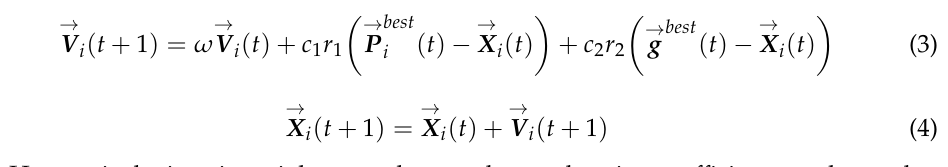
Figure 9. The vector representation of the position and velocity for the PSO. 𝑷(cid:4652)(cid:4652)⃗ 𝒊 (cid:4666)𝒕(cid:4667) is the personal best of ith particle and 𝒈(cid:4652)(cid:4652)⃗(cid:4666)𝒕(cid:4667) is the global best of the entire swarm at the time step 𝑡 . 𝑿(cid:4652)(cid:4652)⃗ 𝒊 (cid:4666)𝒕(cid:4667) is the current position and 𝑽(cid:4652)(cid:4652)⃗ 𝒊 (cid:4666)𝒕(cid:4667) is the current velocity of the ith particle at the time step t. 𝑿 (cid:4652)(cid:4652)⃗ (cid:4666)𝑡(cid:4667) and 𝑽 (cid:4652)(cid:4652)⃗ (cid:4666)𝑡(cid:4667) possess similar dimensions;for each time step, the particle movement is represented by 𝑽(cid:4652)(cid:4652)⃗(cid:4666)𝑡(cid:4667) . The particle best position ( 𝑷(cid:4652)(cid:4652)⃗ (cid:3036)(cid:3029)(cid:3032)(cid:3046)(cid:3047) (cid:4667) is a point for a particular